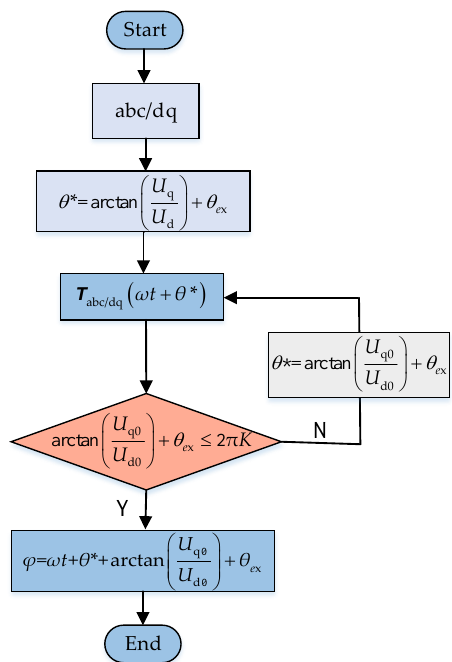
Figure 9. The flow chart of tracking the θ d0 and fine-tuning the angular position of the d 0 q 0 frame.